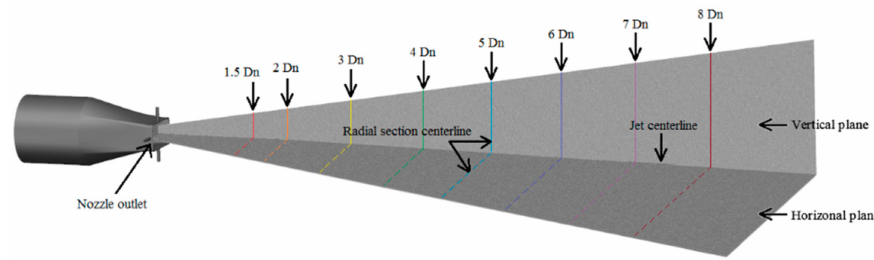
Figure 6. Typical downstream sections.